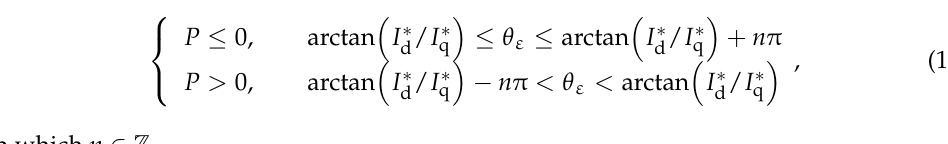
Figure 7. Heat map of the reactive current reference of strategy 1: I ∗ The trajectories of the two di ff erent post-fault initial points (A( t 0 ) and B( t 0 )) are indicated by the green and magenta arrows, respectively. Blue regions denote active power injected from the grid into the DC link of the converter, while red regions denote the regular power direction from the DC link into the grid.